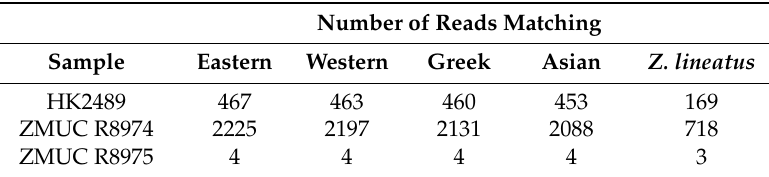
Table 2. Genetic affinity by